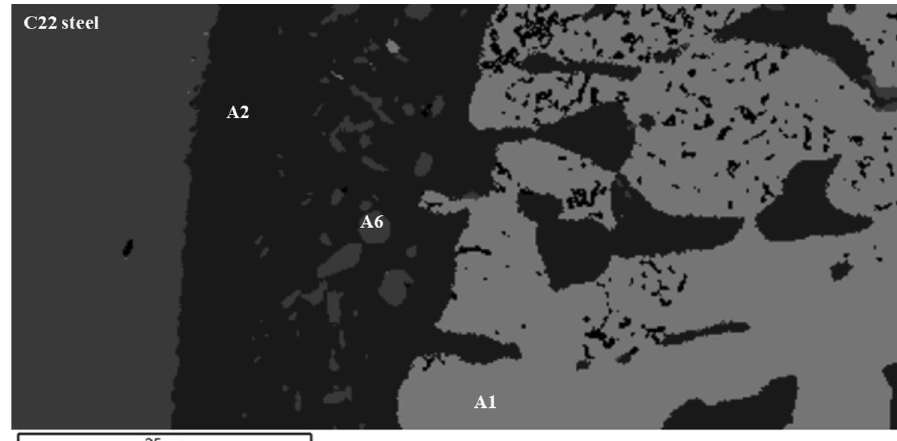
Fig. 5 EBSD image of the coating A: BCC (medium grey), FCC (dark grey) and P2 grey) phases. The phase on the left is the steel